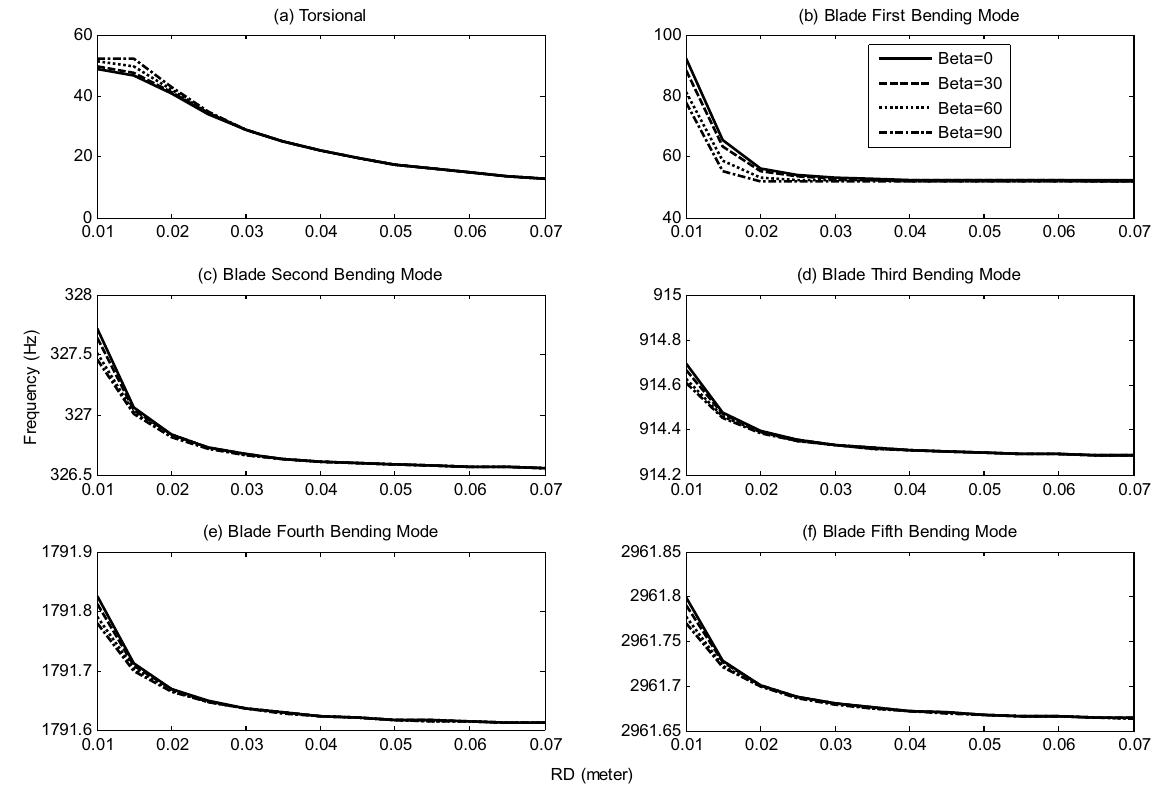
Fig. 4. Natural Frequencies as function of shaft torsional stiffness R D for setting angles: β = 0 ◦ , 30 ◦ , 60 ◦ , 90 ◦ . forces, V A . The elastic blade-bending strain energy for a blade with flexural rigidity EI ( x ) is given